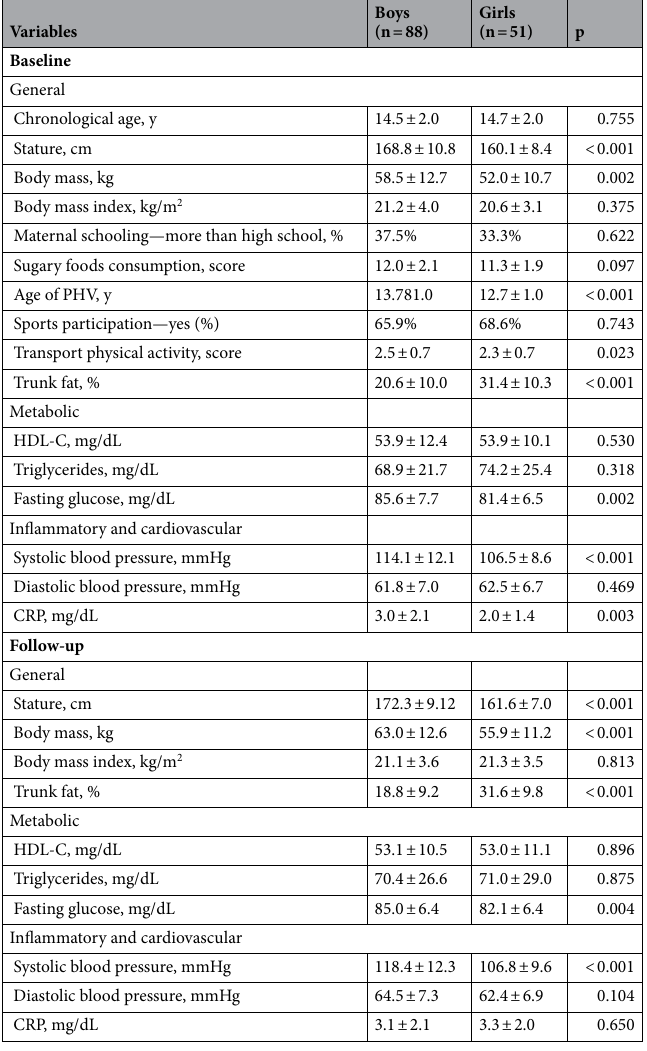
Table 1. Characteristics of the boys and girls. Values are presented using means, frequencies, and standard deviations. PHV, peak of height velocity. CRP, C-reactive protein.